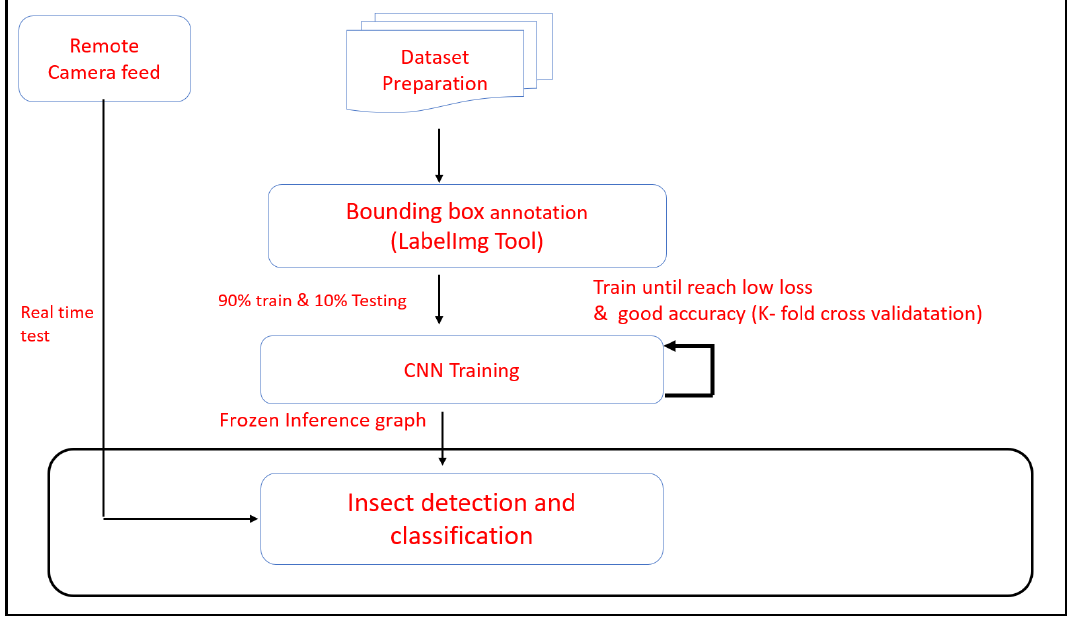
Figure 4. Experimental design